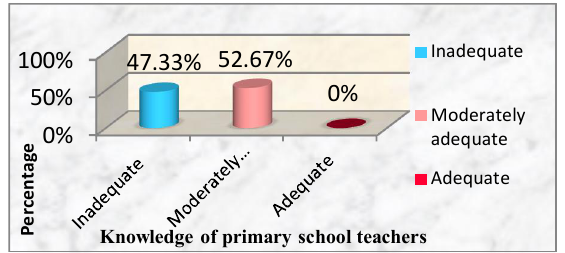
Graph 1: Distribution of primary school children